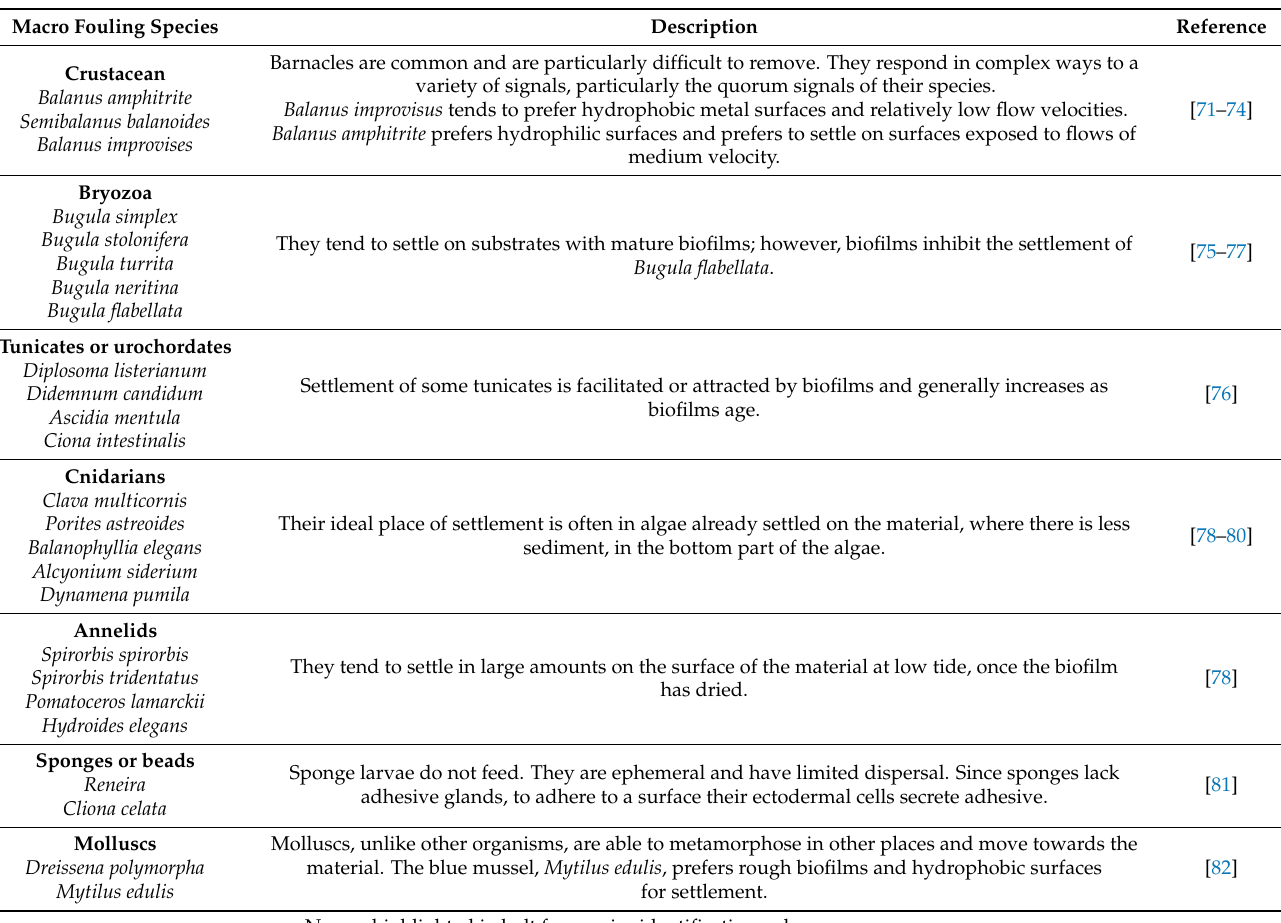
Table 1. Macrofouling